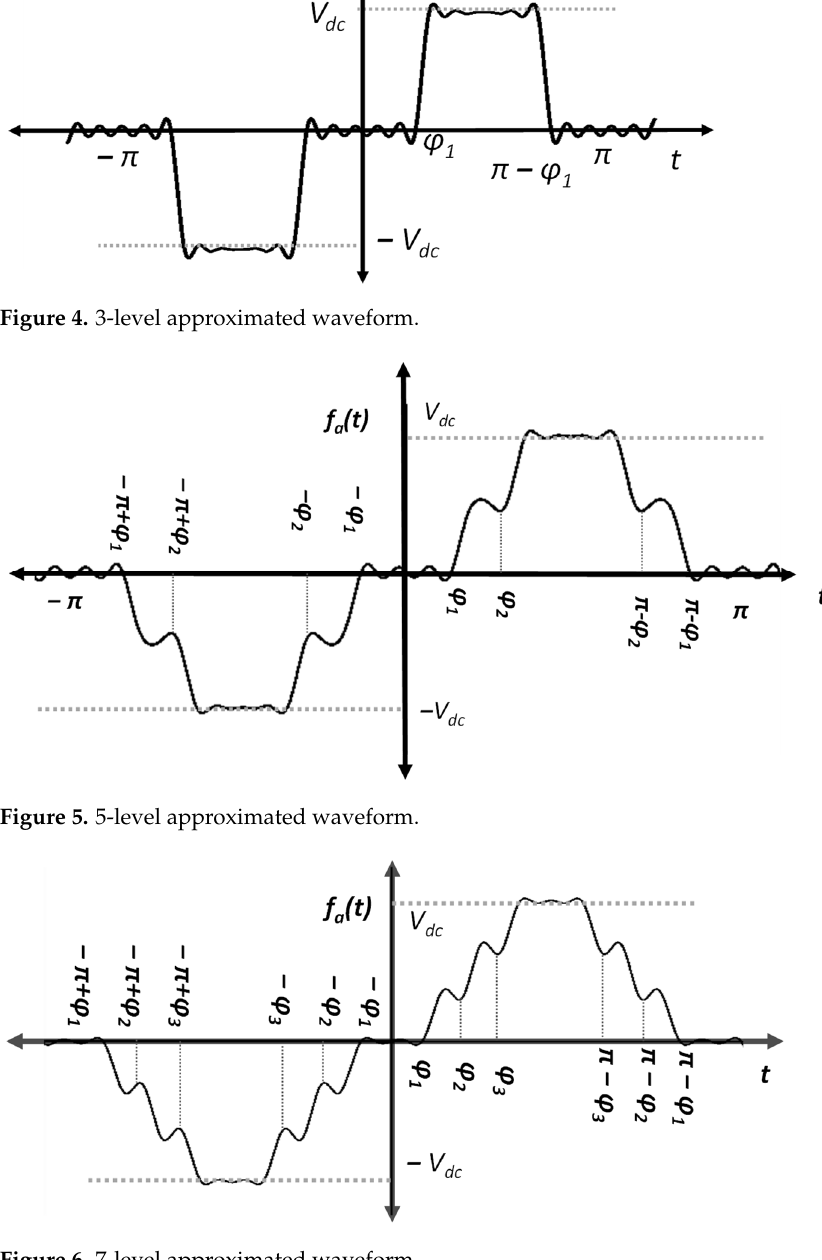
Figure 6. 7-level approximated waveform.